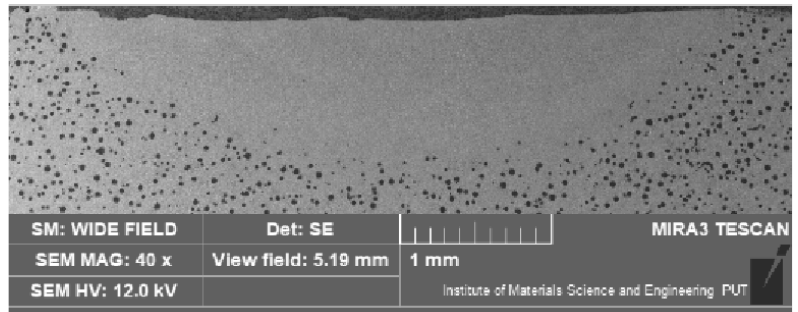
Figure 7. The cross-section of the surface layer of nodular iron after laser alloying with cobalt (electron scanning microscope, etched with nital 3%).